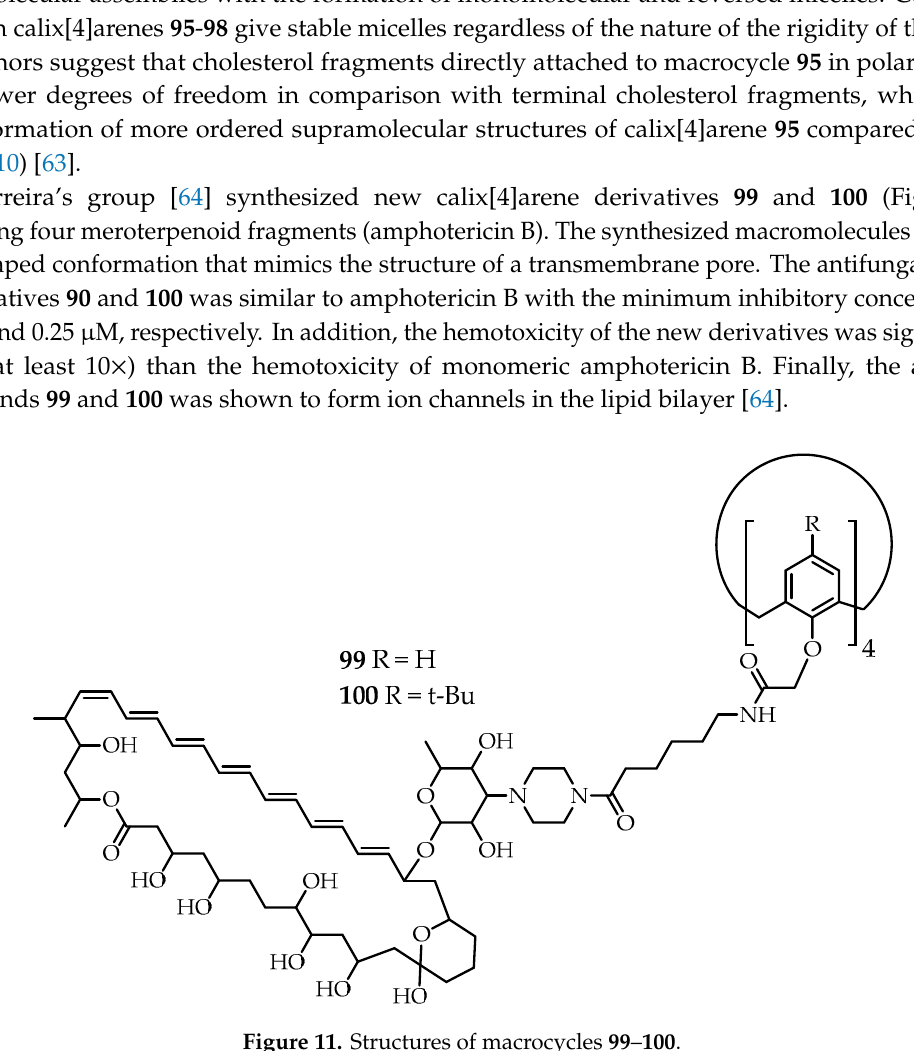
Figure 10. Structures of amphiphilic calix[4]arenes containing cholesterol fragments 96a-b , 97 , 98 .